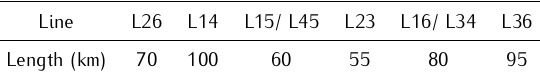
Table 2. Parameters of dc lines (0.02